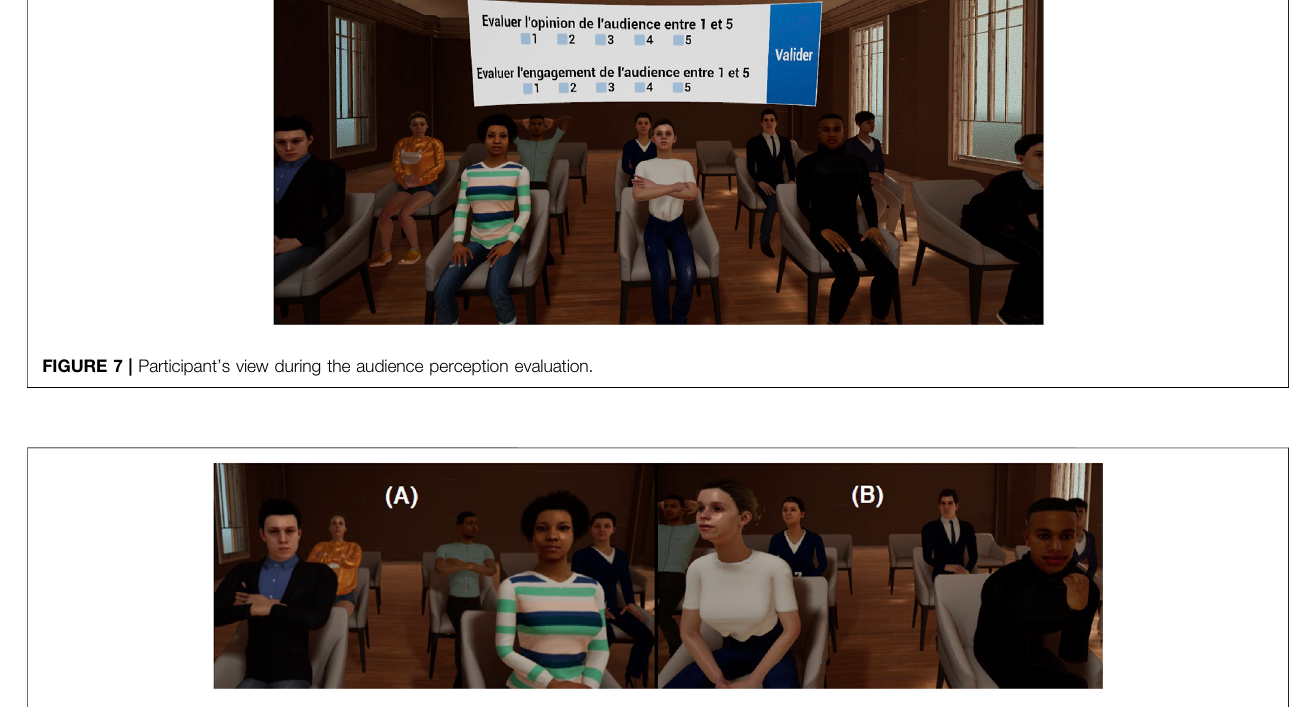
FIGURE 8 | Example of an annoyed (A) and an interested (B) virtual